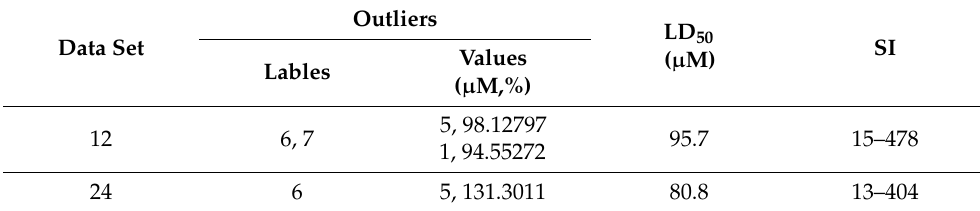
Table 6. Outliers and LD 50 and SI of G5-PDK (12 and 24 h treatments).